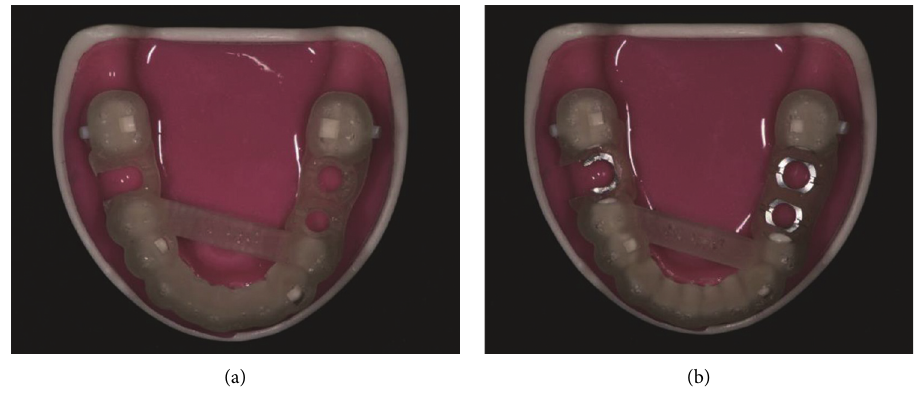
Figure 3: (a) Metal sleeve-free surgical guide. (b) Metal sleeve incorporated surgical guide